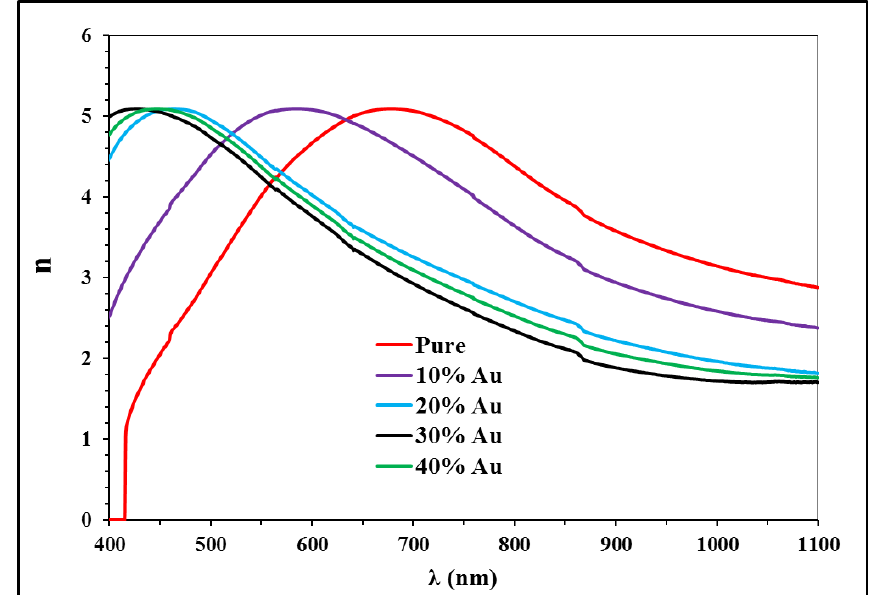
Fig. 13: Refractive index for pure WO